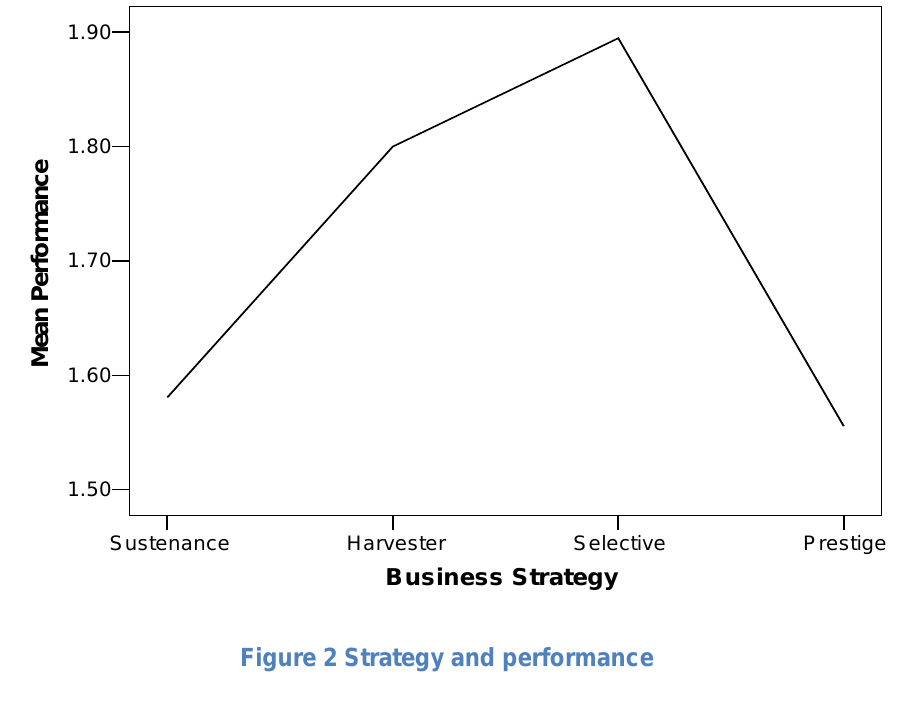
Figure 2: Strategy and Performance Figure 2 Strategy and